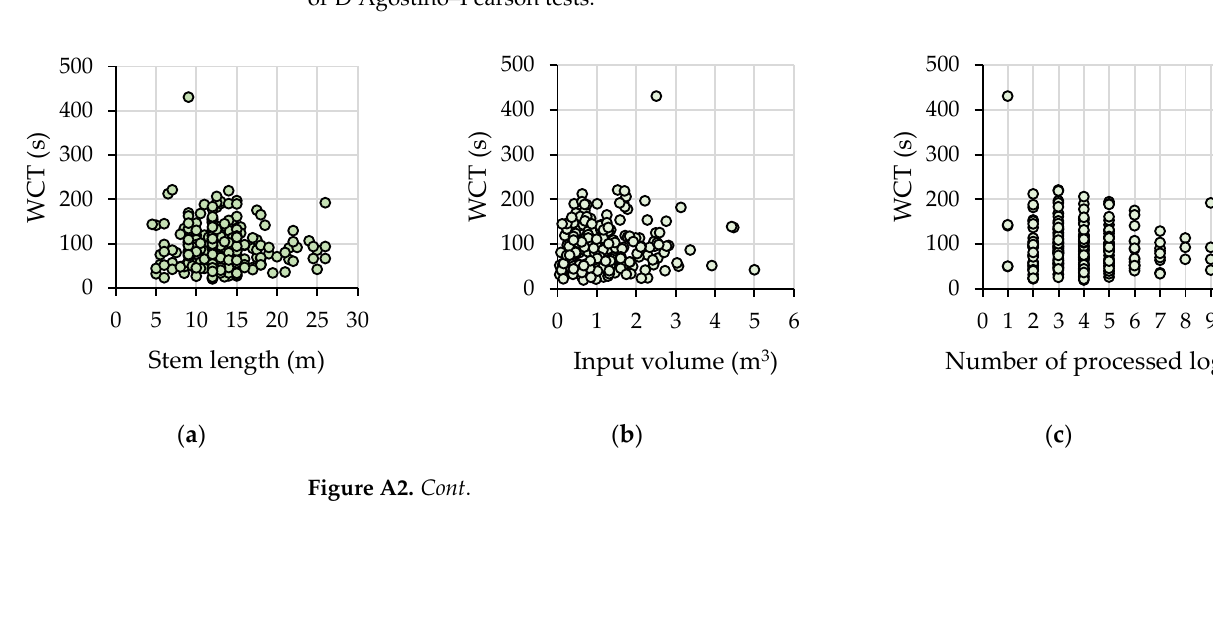
( k ) Figure A2. Scatter plots of the elemental and cycle time consumption variation plotted against the relevant input and output variables: ( a ) work cycle time against stem length; ( b ) work cycle time against input volume; ( c ) work cycle time against number of processed logs; ( d ) grabbing time against stem length; ( e ) grabbing time against input volume; ( f ) piling time against number of